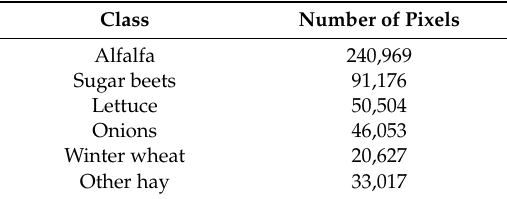
Table 1. Number of pixels for each of the 6 classes in study area 1.